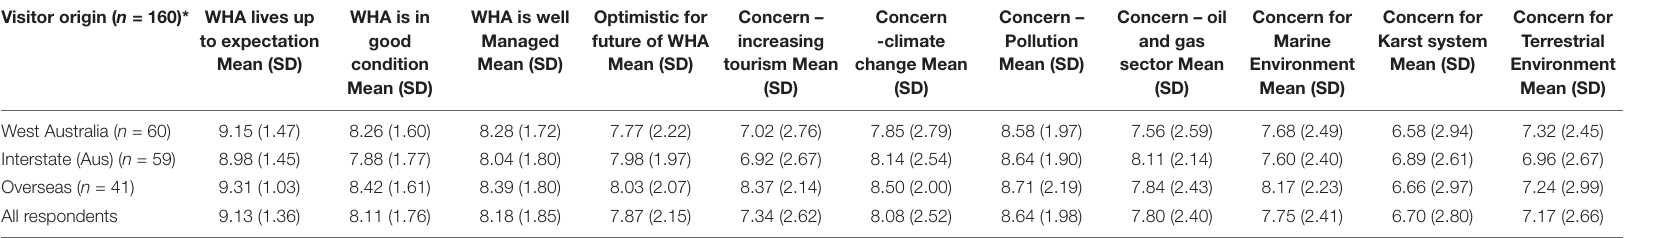
Scores are based on a Likert scale between 1 (representing strongly disagreed) and 10 (representing strongly agreed). *Three respondents did not identify their origin.